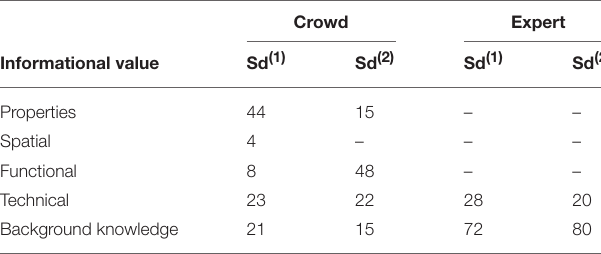
TABLE 5 | Major category design information distribution. TABLE 6 | Combined semiotic and major category